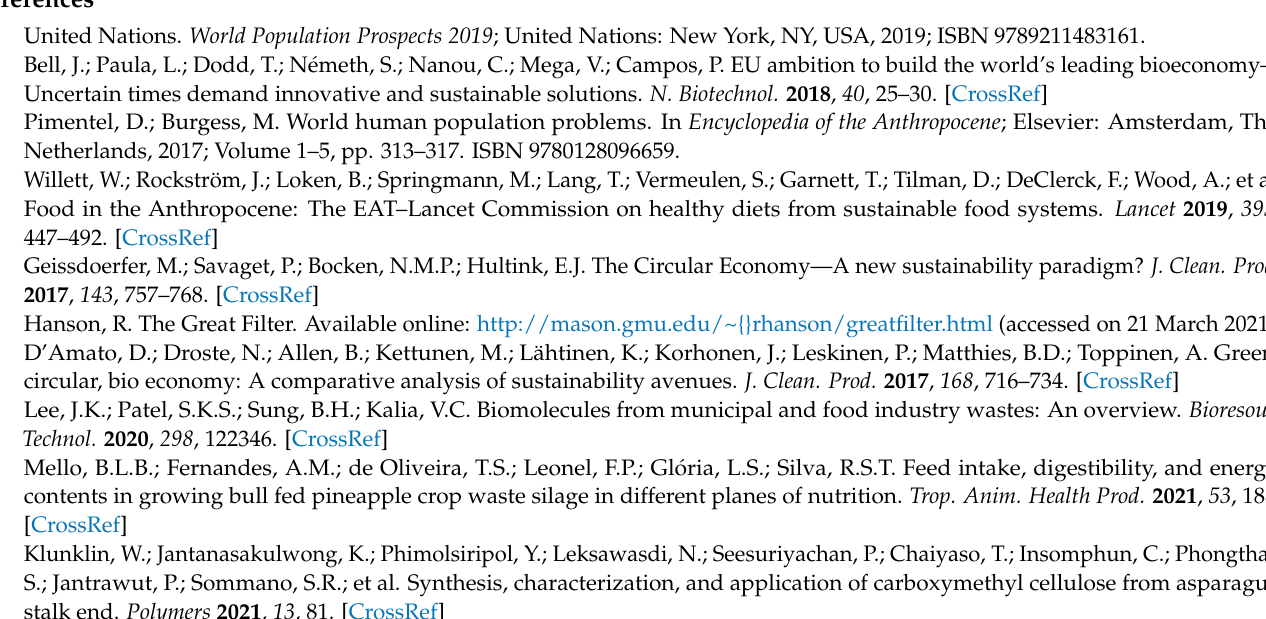
interpretation table, Table S3. Quantification of IL-1 β , IL-6, IL-8 and TNF- α levels in macrophages without and with inflammatory stimulus (LPS), Supplemetary